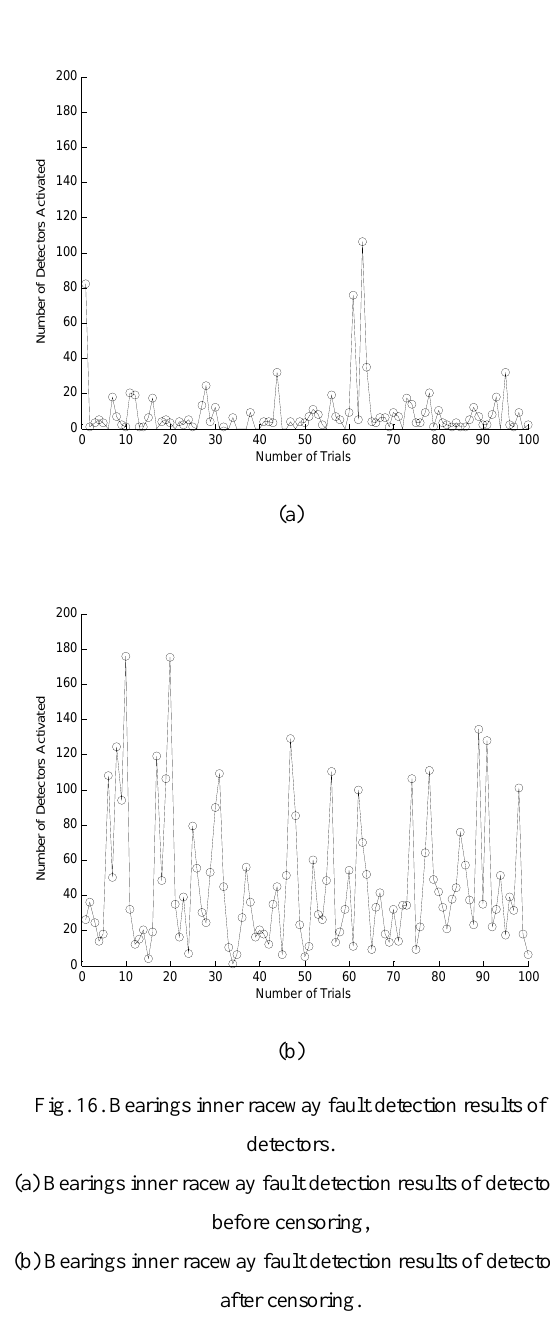
Fig. 15. of feature signals of bearings in Example 3 (b). V (a) of feature signal of healthy bearings, V (b) of feature signal of faulty bearings with inner raceway V fault.